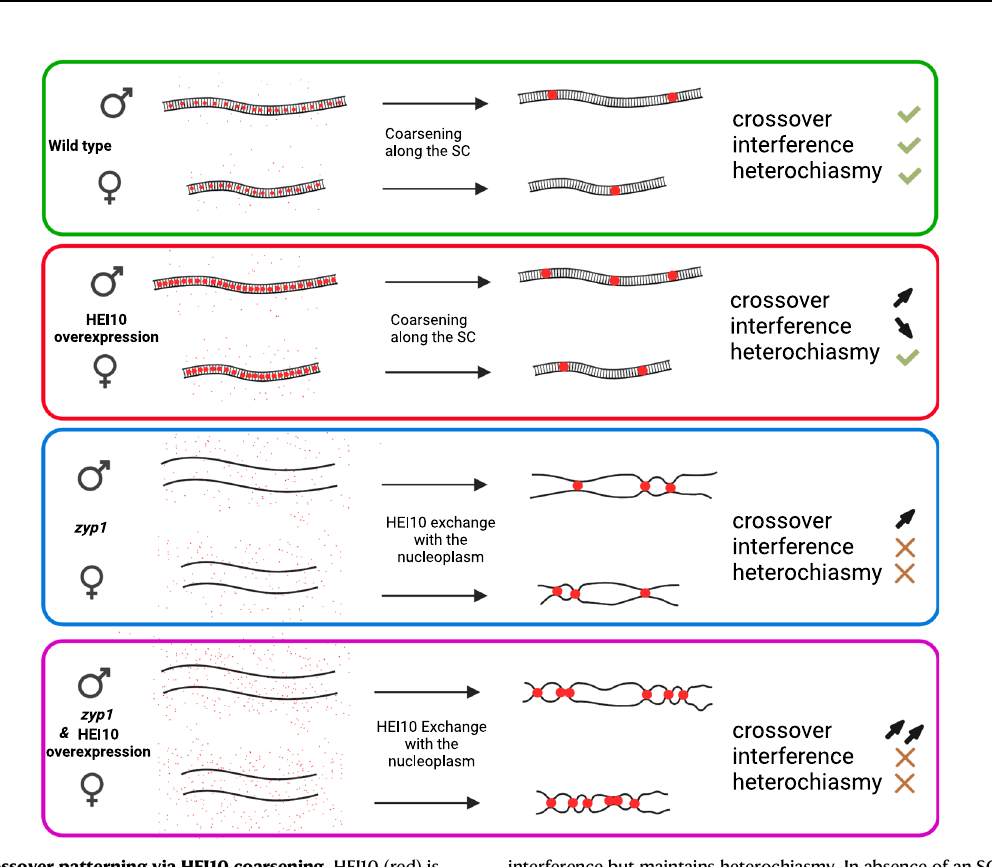
interference but maintains heterochiasmy. In absence of an SC ( zyp1 ), HEI10 is exchanged directly between the foci and the nucleoplasm abolishing both inter- ference and heterochiasmy, and the number of foci depends on HEI10 expression level. Created with